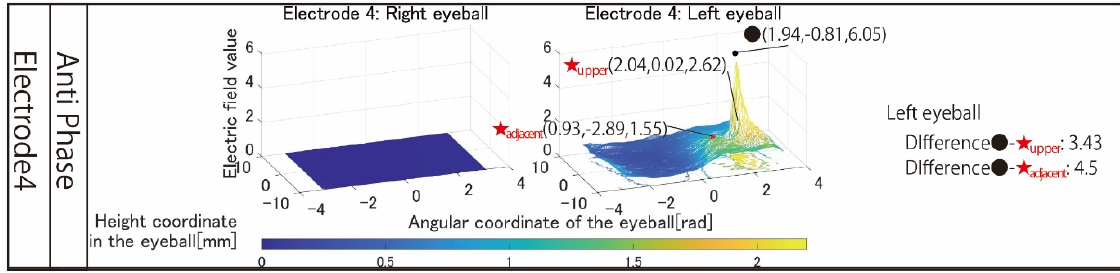
Figure 11. Simulation result with revised electrode arrangement to stimulate left eyeballs.